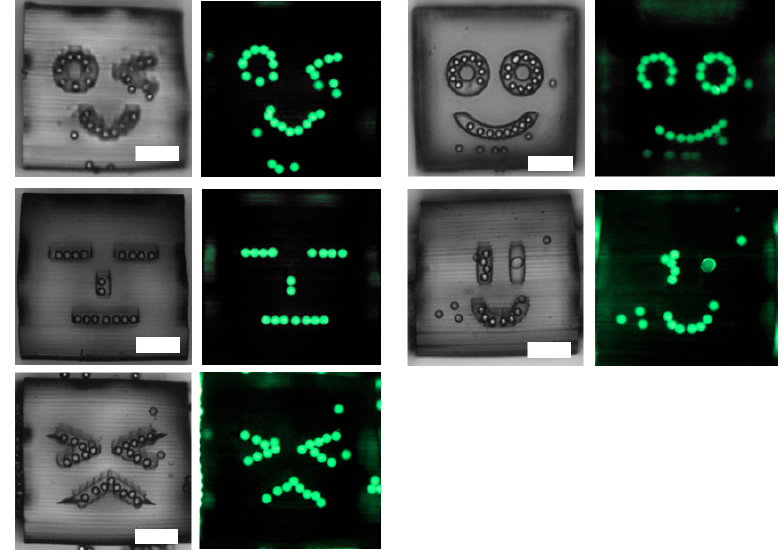
Figure 5. Assembly of beads on faces engraved on five faces of a cube. Left: Bright field images and Right: Fluorescent images. All scale bars represent 100 µ m.